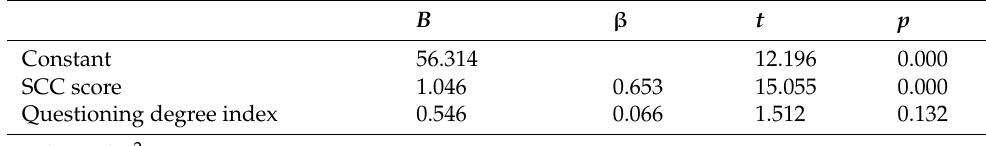
Table 3. Regression forthe SOC-29 total score.